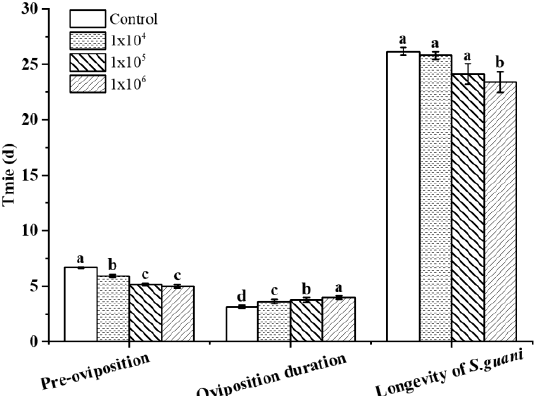
Figure 4. Performance of S. guani under different concentrations of B. bassiana spore suspensions: pre-oviposition, Oviposition duration, and Longevity of S. guani under different concentrations of B. bassiana spore suspension. Different letters above the bars indicate significant differences (Mean ± SE, n = 30 in each treatment, p < 0.05).